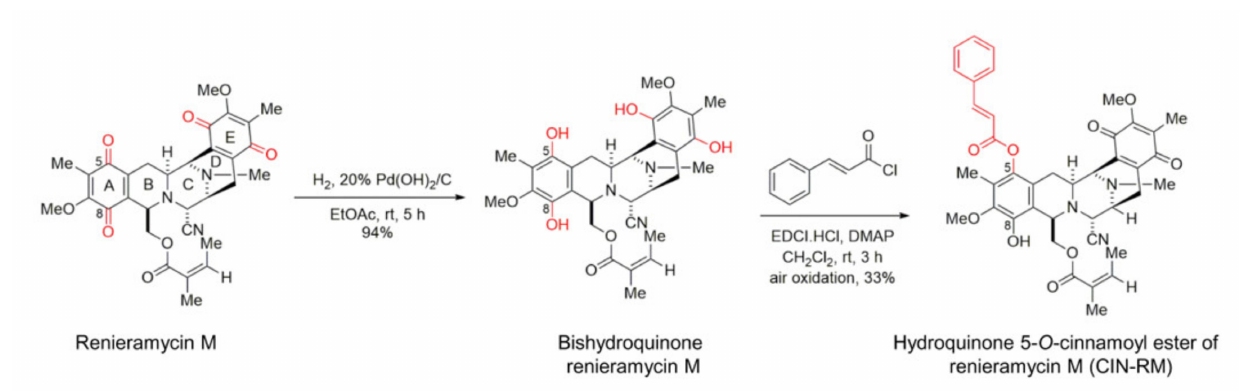
Figure 1. Semi-synthesis of hydroquinone 5- O -cinnamoyl ester of renieramycin M